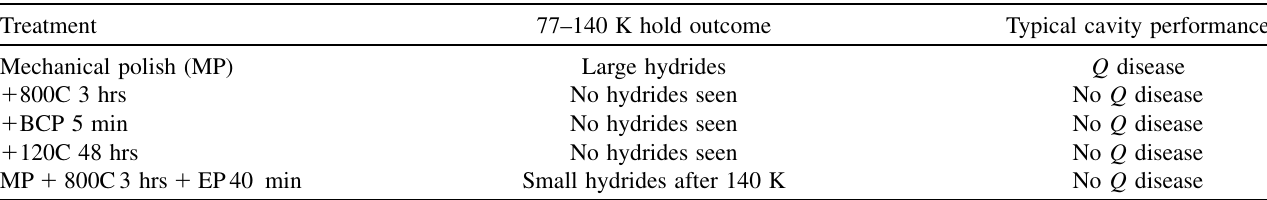
TABLE I. Effect of different